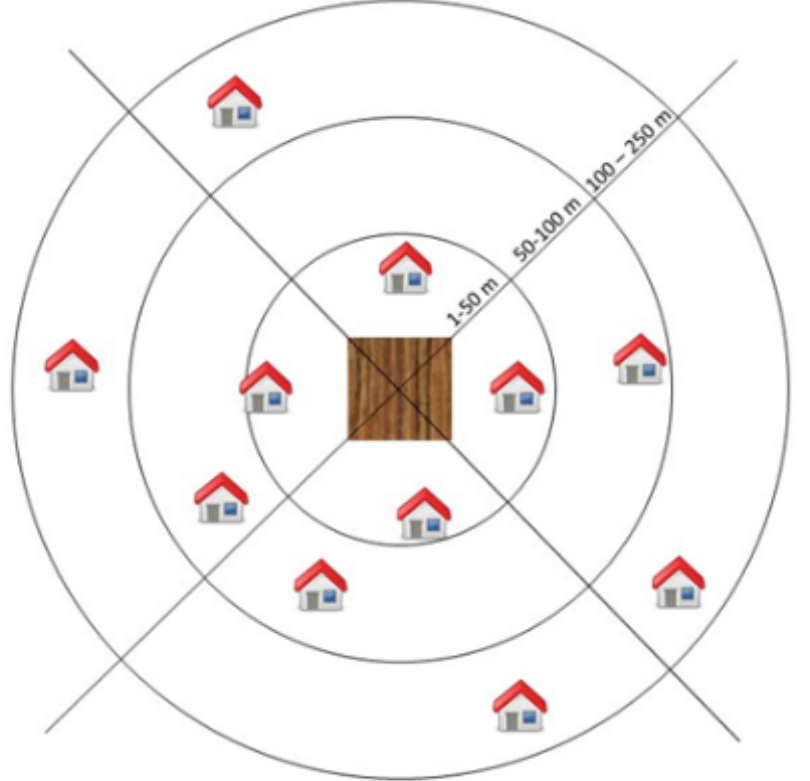
Figure 3. Selection of homes at different distances from selected